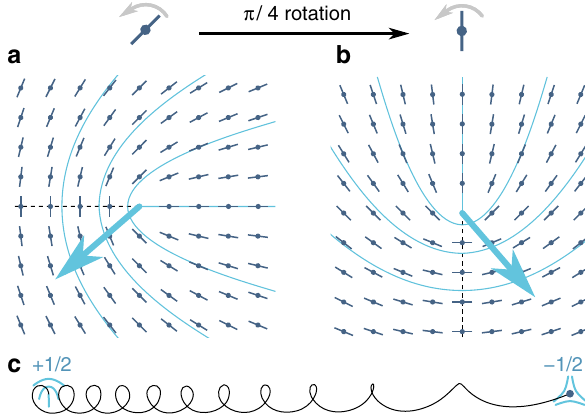
Fig. 2 Rotation of a + 1/2 defect and consequent recombination with its − 1/ 2 partner. a The combined in fl uence of the achiral ( ζ ) and chiral ( ζ c ) active forces endows a + 1/2 defect with a self-propulsion velocity (blue arrow) = ζ Þ with the main direction of the defect that makes an angle tan (cid:2) 1 ð ζ c (dashed line). b As each particle rotates autonomously, this main direction rotates as well. The defect velocity thus also rotates at a constant rate Ω , and the self-propelling defect moves in a circle. c When in the vicinity of a − 1/2 defect (dark blue circle, assumed stationary here), the circling + 1/2 defect is additionally attracted to it, leading to a recombination trajectory materialised by the solid black line (see the Supplementary Note 5 for the defect equations of